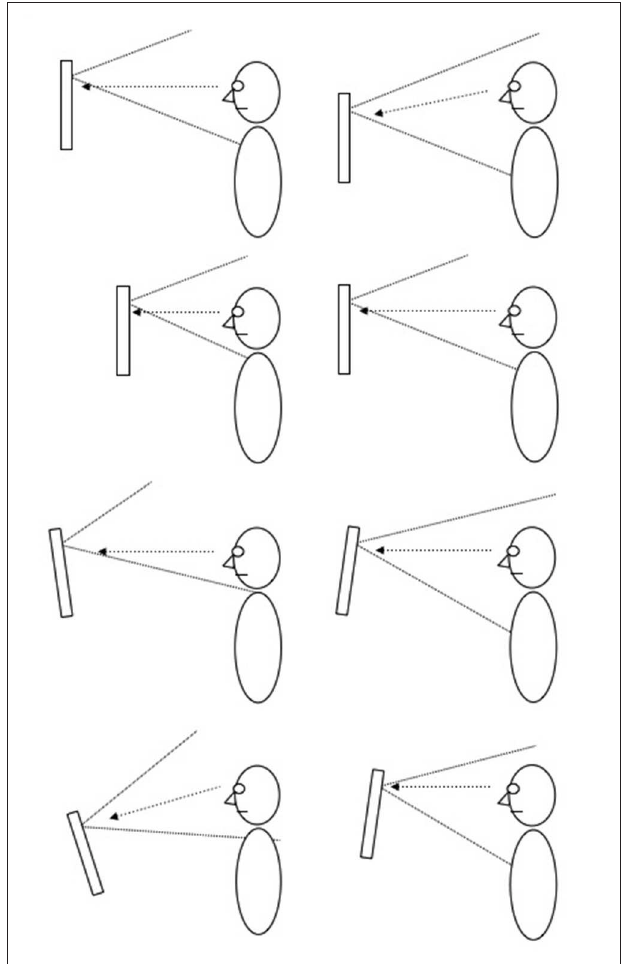
FIGURE 9 | Eight ways to interact with your smartphone (and your own image in its preview screen) while taking a selfie. The left column represents interactions that yield relatively higher facial prominence. The right column, interactions that yield relatively lower prominence. Facial prominence is reduced by lowering the smartphone (first row); increasing its distance from the viewpoint (second); tilting the smartphone toward the viewpoint (third); or by a combination of the above. The configurations shown in the fourth row correspond to the combination that is most consistent with the pattern of our